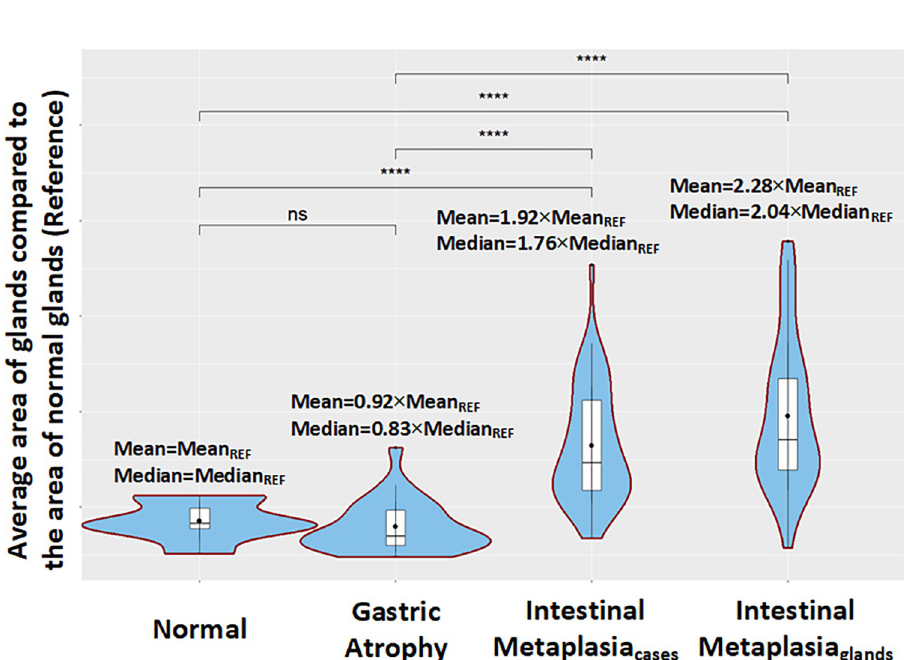
Fig 8. Box plots comparing the average area that glands cover per WSI between normal, Gastric Atrophy (GA) and Intestinal Metaplasia (IM) cases included in GAGL dataset. For the comparison the average area of normal glands is used as reference. For IM cases, average area of glands per IM case and average area of glands classified as IM is estimated.